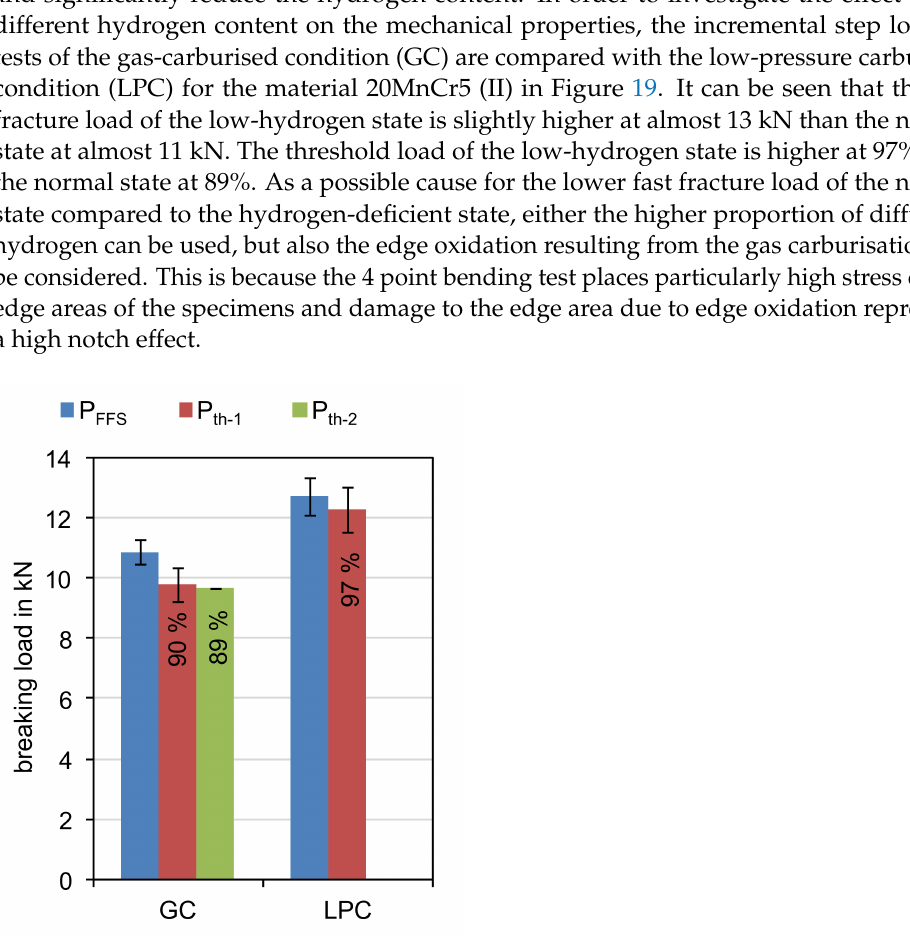
Figure 19. Comparison of the incremental step loading test between the industrial standard (gas carburising, GC) and the low hydrogen condition (low-pressure carburising, LPC); material: 20MnCr5 (II); x ± s, n =